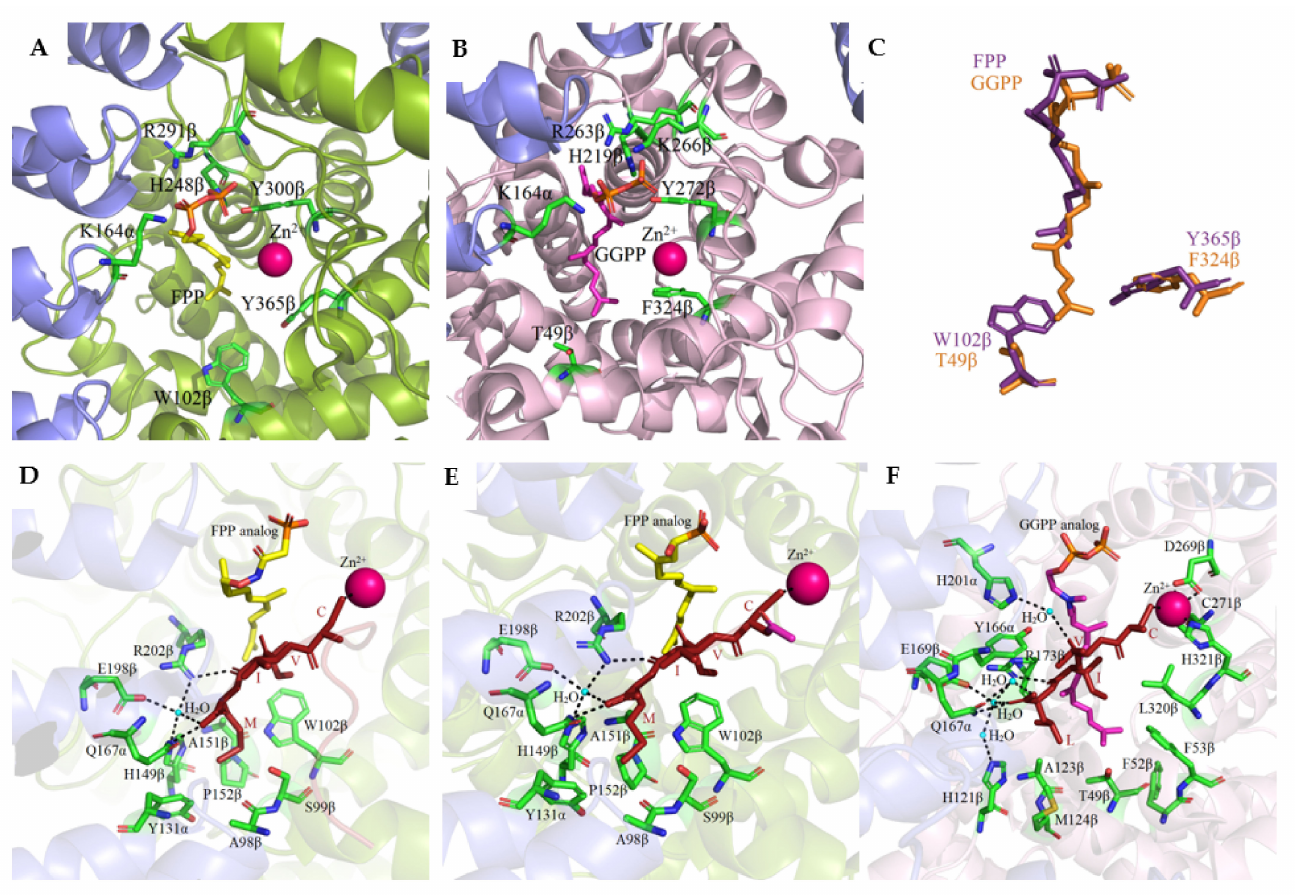
Figure 4. The co-crystal structure of FTase complexed with a farnesyl diphosphate substrate ( A ) (PDB: 1FT2) and with a K-Ras4B peptide substrate and FPP analog ( D ) (PDB: 1D8D) and with a CVIM peptide and FPP analog ( E ) (PDB:1QBQ) and GGTase-I complex with geranylgeranyl diphos- phate ( B ) (PDB: 1N4P) and with a GGPP analog and a KKKSKTKCVIL peptide ( F ) (PDB: 1N4Q). Comparison of isoprenoid binding in FTase (PDB: 1FT2) and GGTase-I (PDB: 1N4P) ( C ). (Created in the PyMOL Molecular Graphics System, Version 2.5.2 Schrödinger,